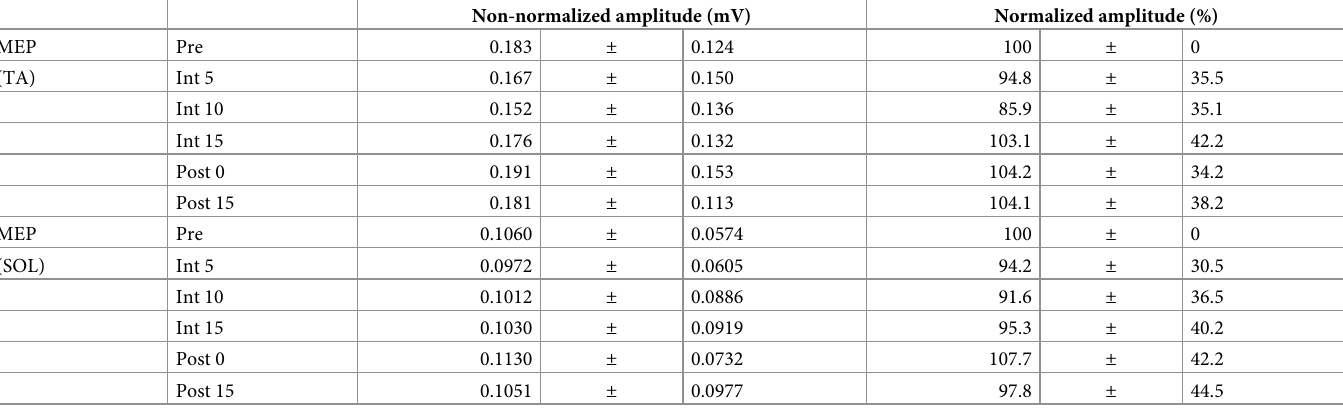
Table 1. Average non-normalized and normalized (% of Pre) amplitudes of MEP with SDs in the rest condition before intervention (Pre), after first block (Int 5), after second block (Int 10), after third block (Int 15), immediately after intervention (Post 0), and 15 min after intervention (Post 15).